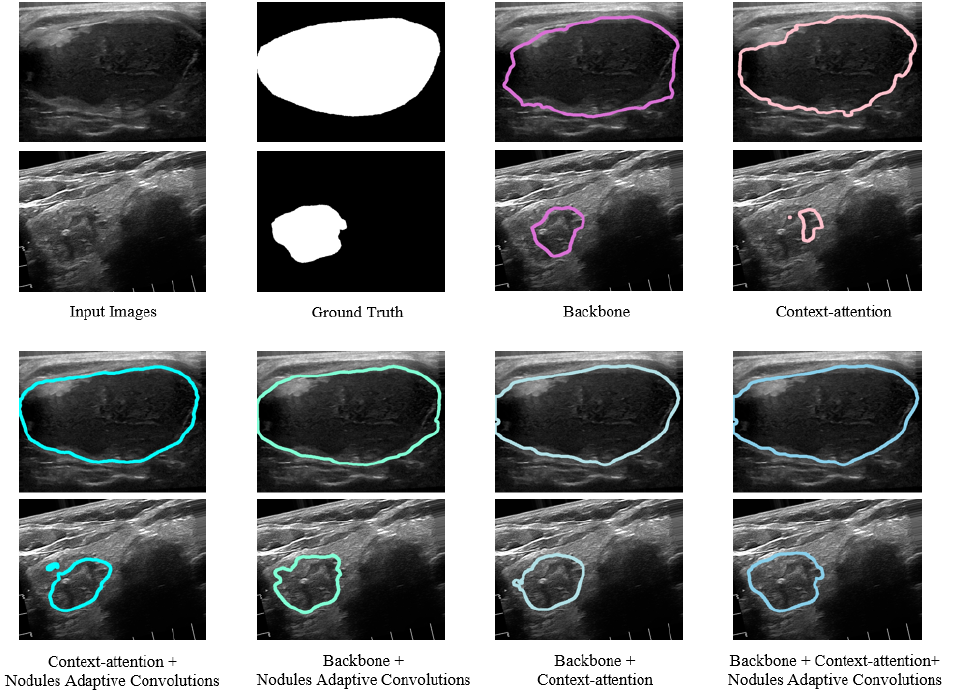
Figure 10. Qualitative comparison of various modules selections by visualization. A large nodule at the center of the image and a small nodule at the edge of the image are selected. The predictions of the complete network structure of LCA-Net are closest to the ground truth and keep more delicate